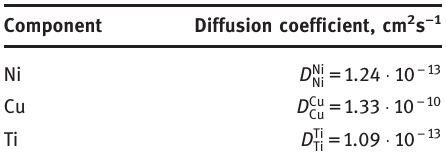
Table 1: The diffusion coefficient of pure Cu, Ni and Ti.